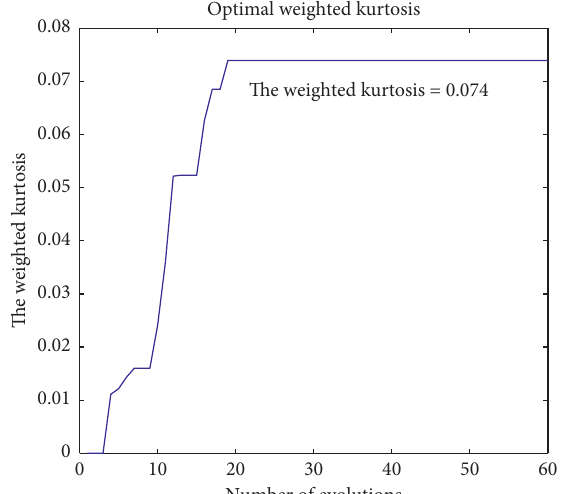
Figure 4: Search process for the optimal weighted kurtosis.